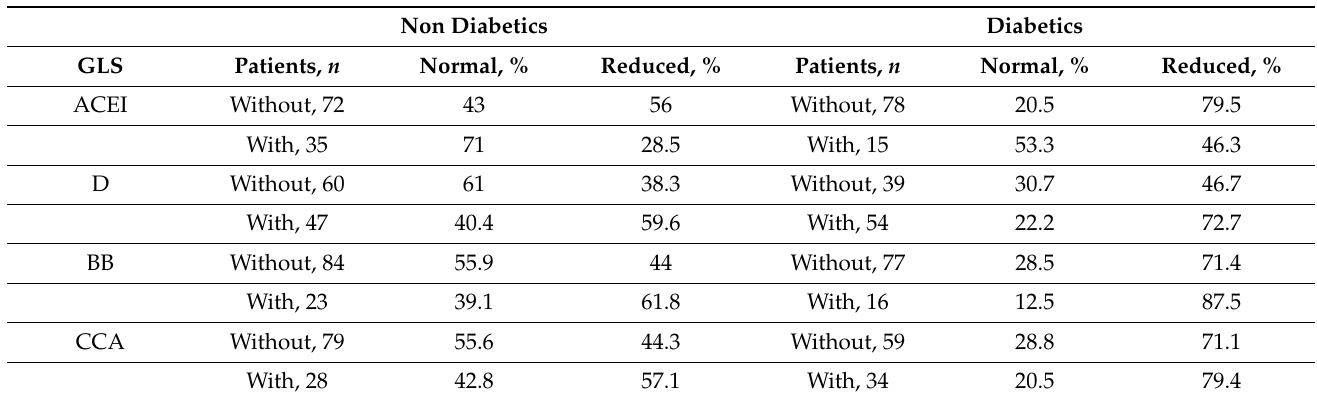
Table 6. Impact of treatment of HBP on GLS